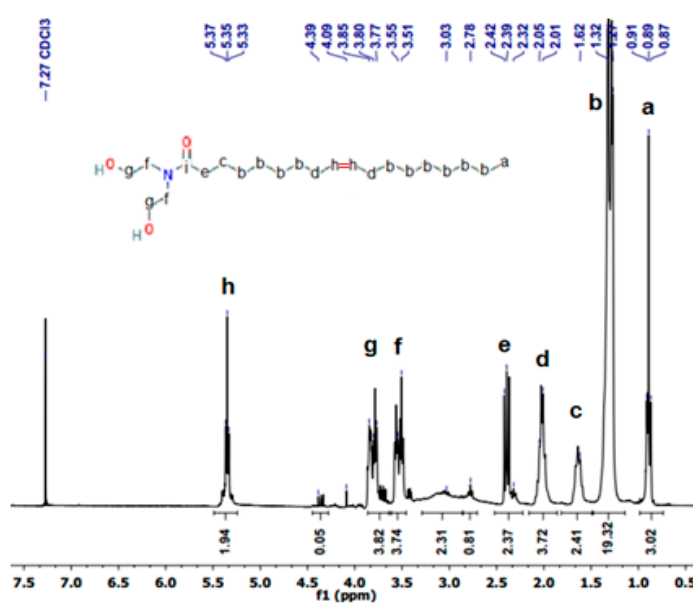
Figure 4. 1 H NMR spectrum of OADA.